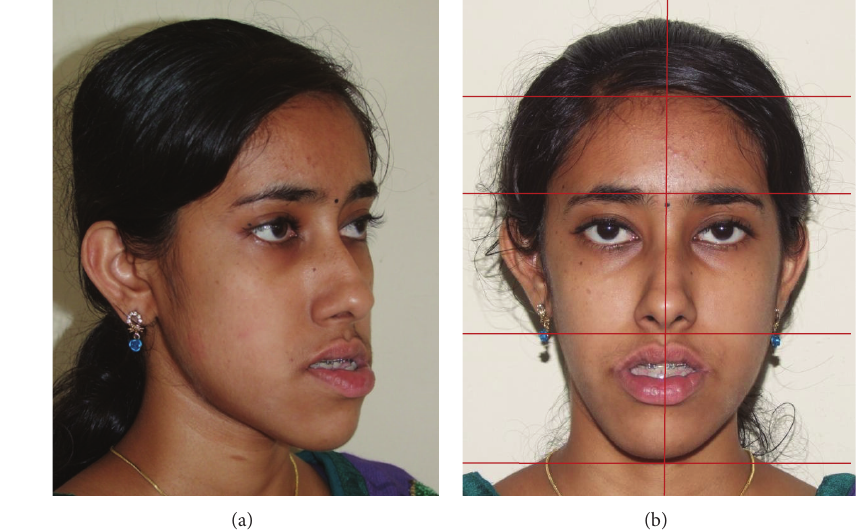
Figure 8: Presurgical face: (a) oblique, and (b) vertical proportions and